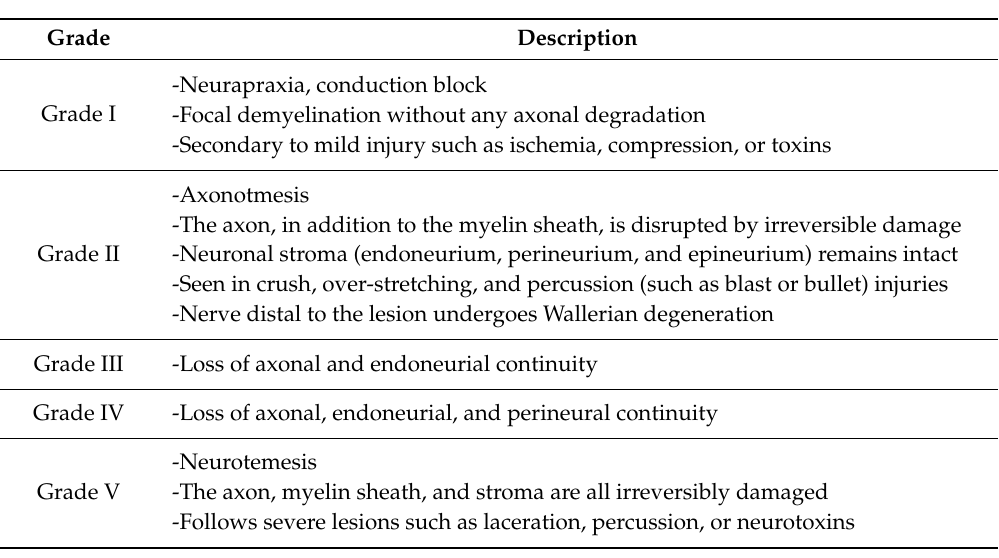
Table 1. Peripheral Nerve Injury Grading